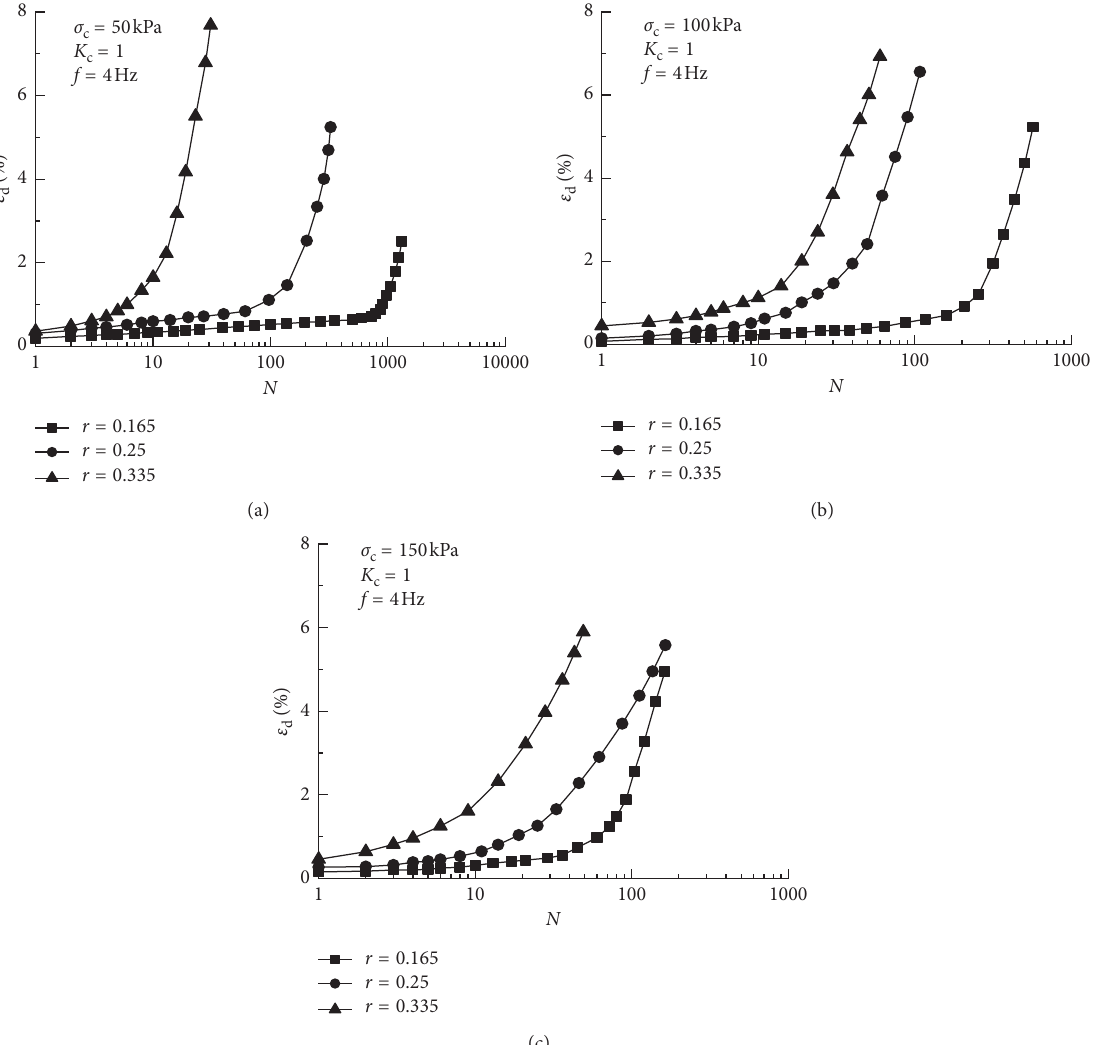
� 50kPa, (b) σ � 100kPa, and (c) σ c